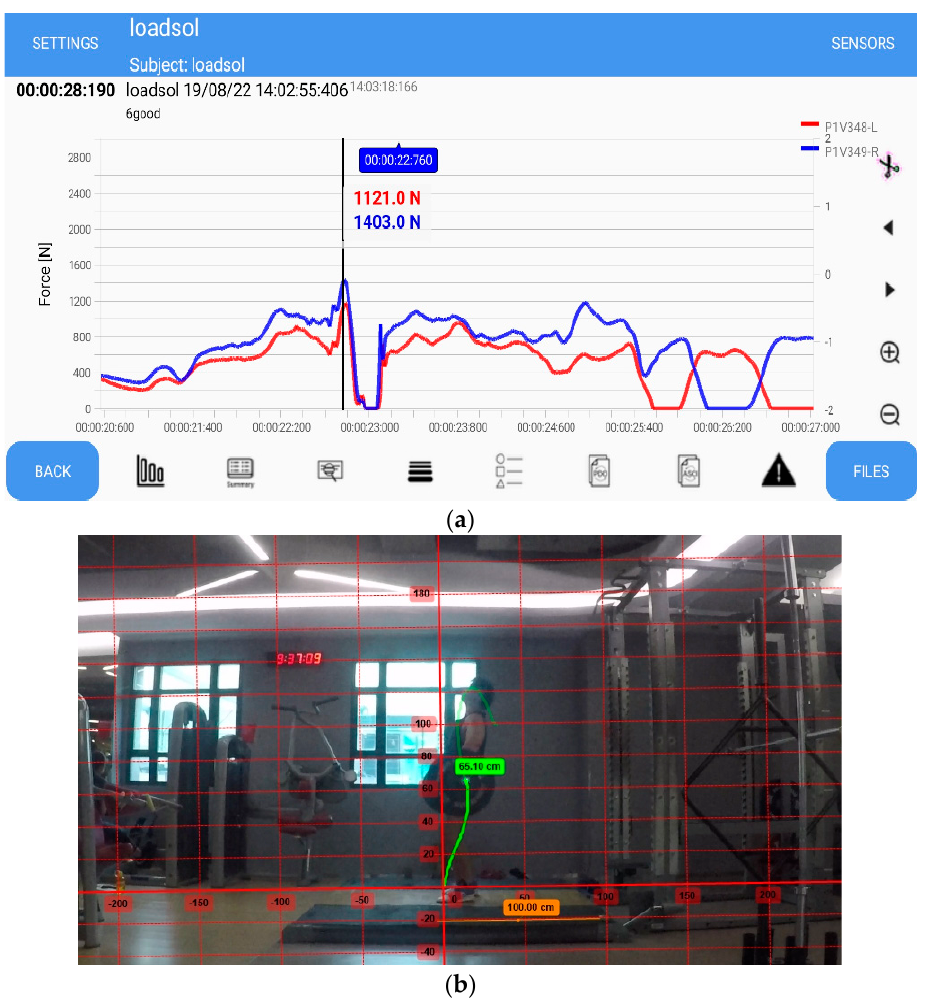
Figure 1. ( a ) Screenshot of a force − time profile recorded using the loadsol − s Android application; ( b ) screenshot of video tracking of barbell trajectory using Kinovea freeware. ( b ) screenshot of video tracking of barbell trajectory using Kinovea